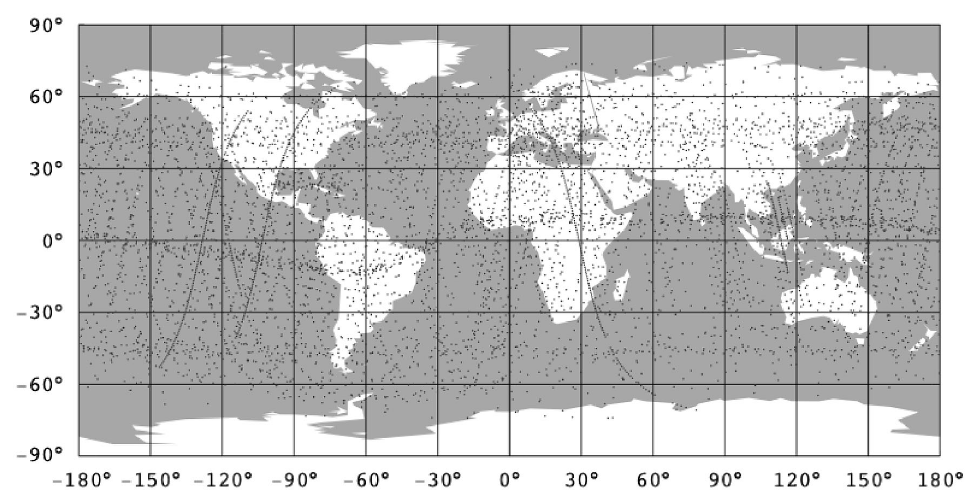
Fig. 18.11. Geographical distribution of the available profiles: IK-19